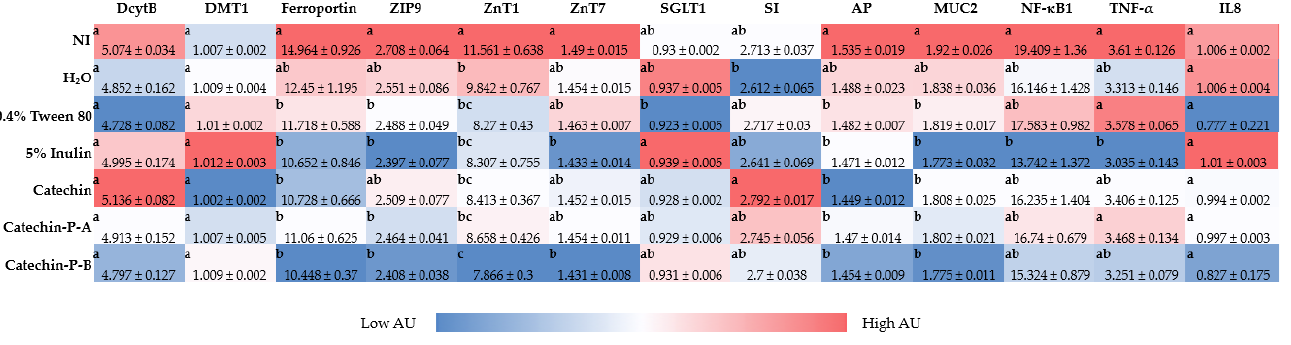
Figure 2. Effect of the intraamniotic administration of experimental solutions on intestinal gene expression. Values are the means ± SEM, n = 10. a–c Per gene (in the same column), treatments groups not indicated by the same letter are significantly different ( p < 0.05). NI, No Injection; Catechin-P-A, Catechin pentaacetate; Catechin-P-B, Catechin pentabutanoate. DcytB, Duodenal cytochrome